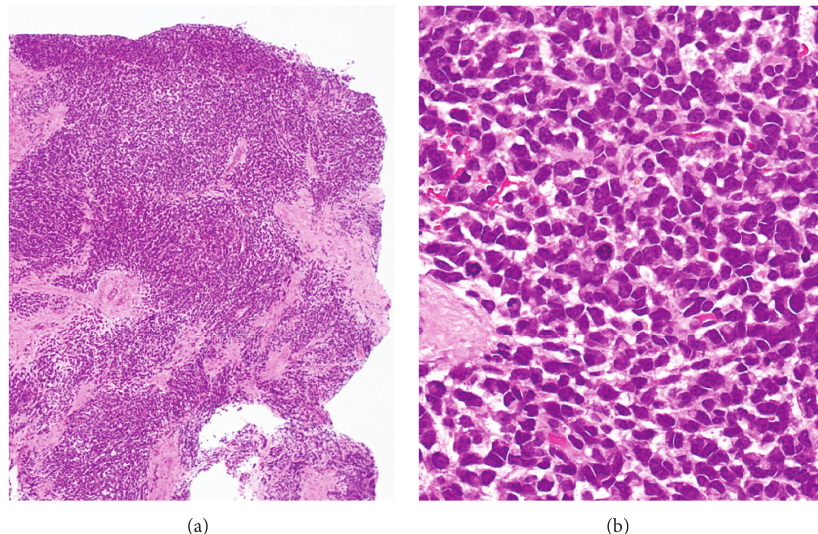
Figure 2: Histological findings of the biopsy specimen of the buttock tumor, showing a poorly differentiated round cell malignant neoplasm, growing in sheets. The tumor cells had scant, pale eosinophilic cytoplasm. Hematoxylin and eosin staining, original magnification × 100 (a) and × 400 (b).